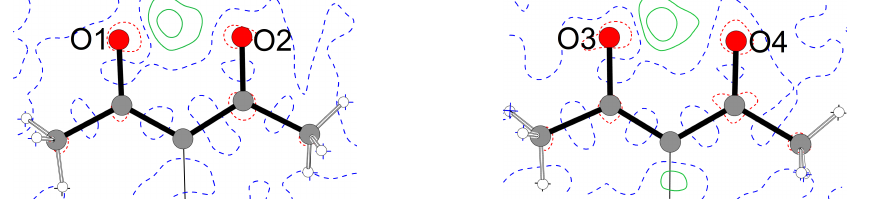
Figure 4. Difference Fourier contour map [30] of the acetylacetone moiety in both molecules contained in the asymmetric residue of 1 . Contour lines are drawn at 0.2 e Å negative difference, blue: zero lines).